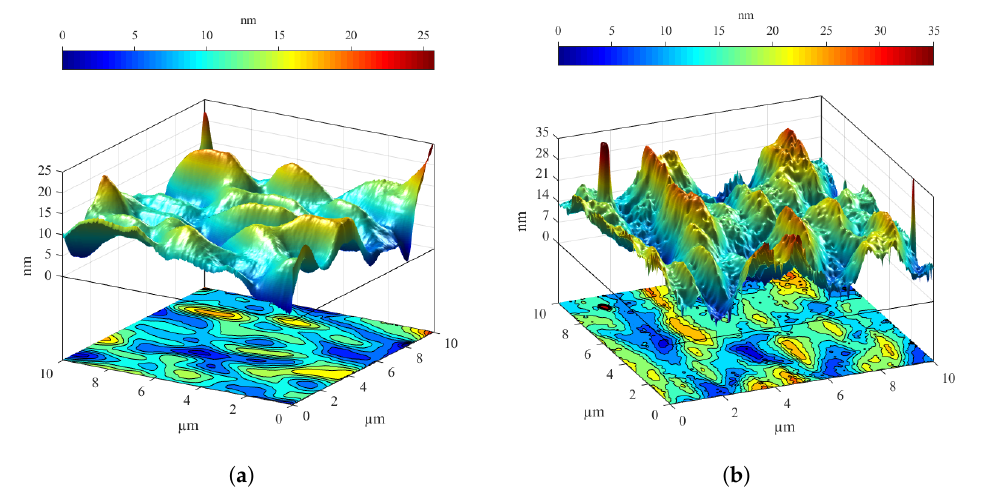
Figure 9. The differences ( a ) before and ( b ) after thermal processing of the cell scanned by an atomic force microscope (AFM) are considerable. The surface structure is entirely different. The average height of the feature on the surface changed from 7.16nm to 15.73nm after thermal heating